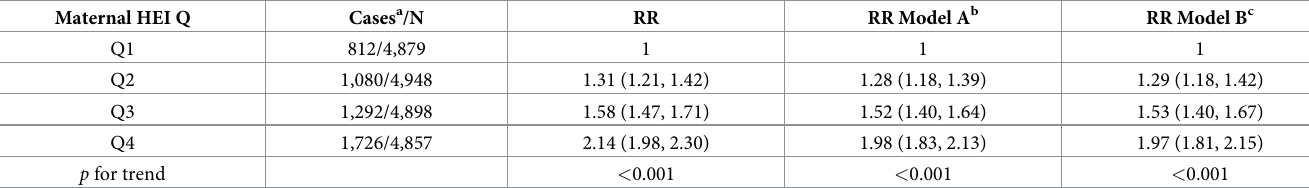
Table 5. Maternal prenatal dietary habits as predictor of offspring dietary habits at age 14 ( n =